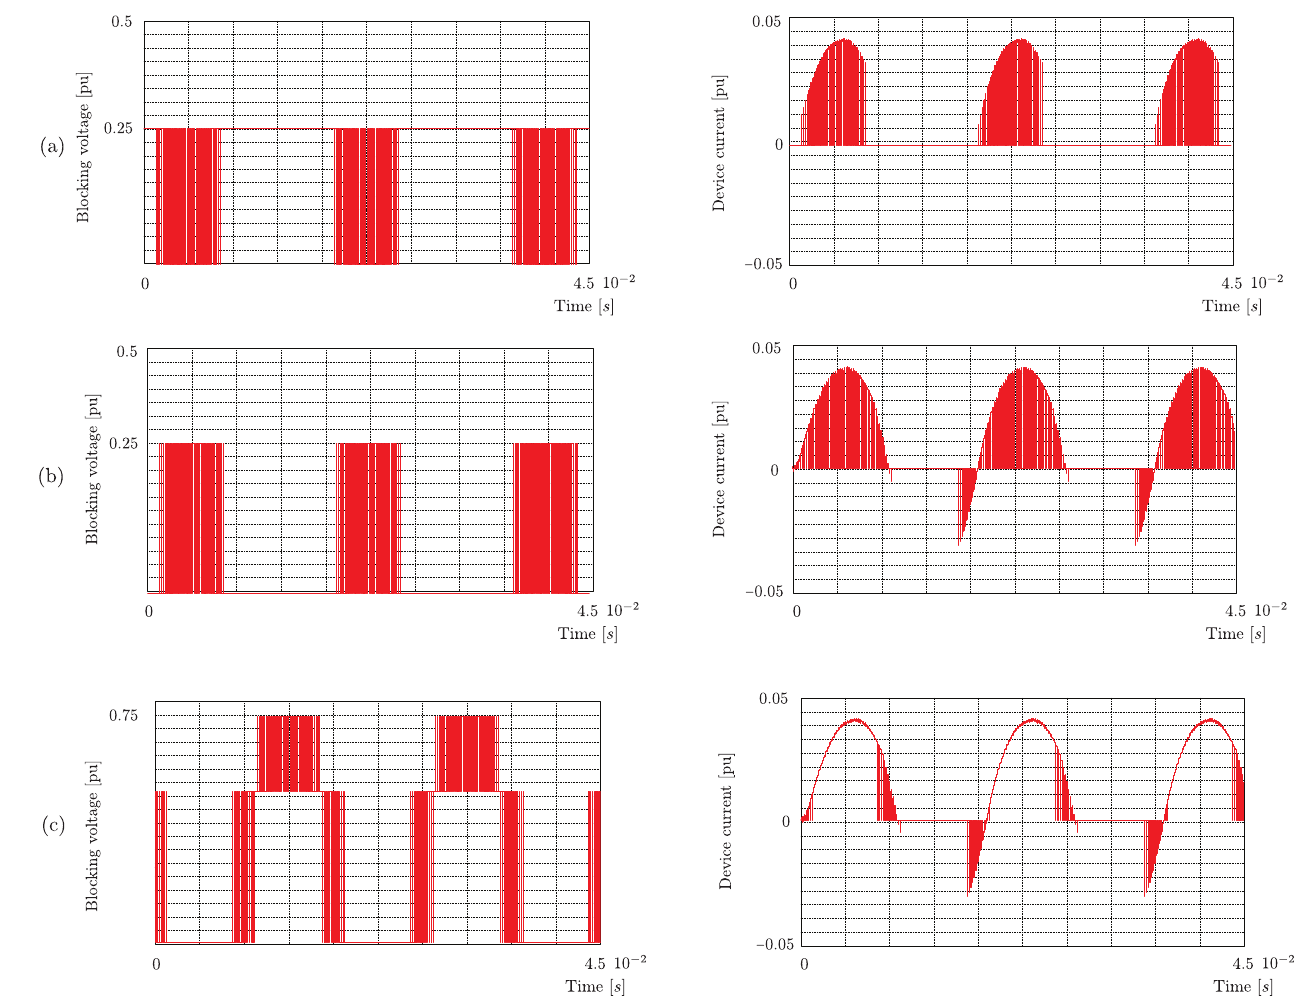
Figure 11. Voltage and current waveforms of the semiconductor switches in the four-level quasi-nested (4L-QN) inverter. ( a ) Switches S 1 , S 3 ; ( b ) switches S 1 , S 3 ; ( c ) switches S 2 , S 2